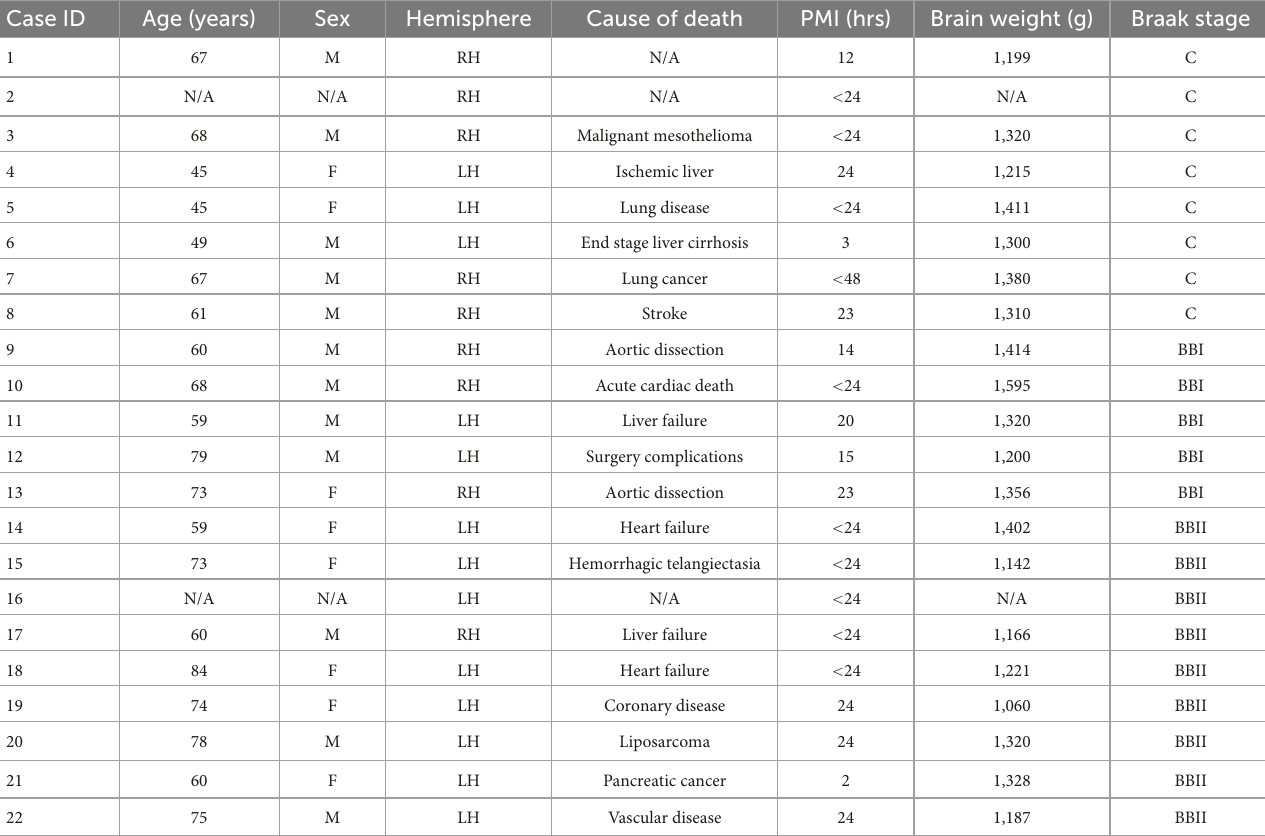
TABLE 1 Demographic information for cases used in this